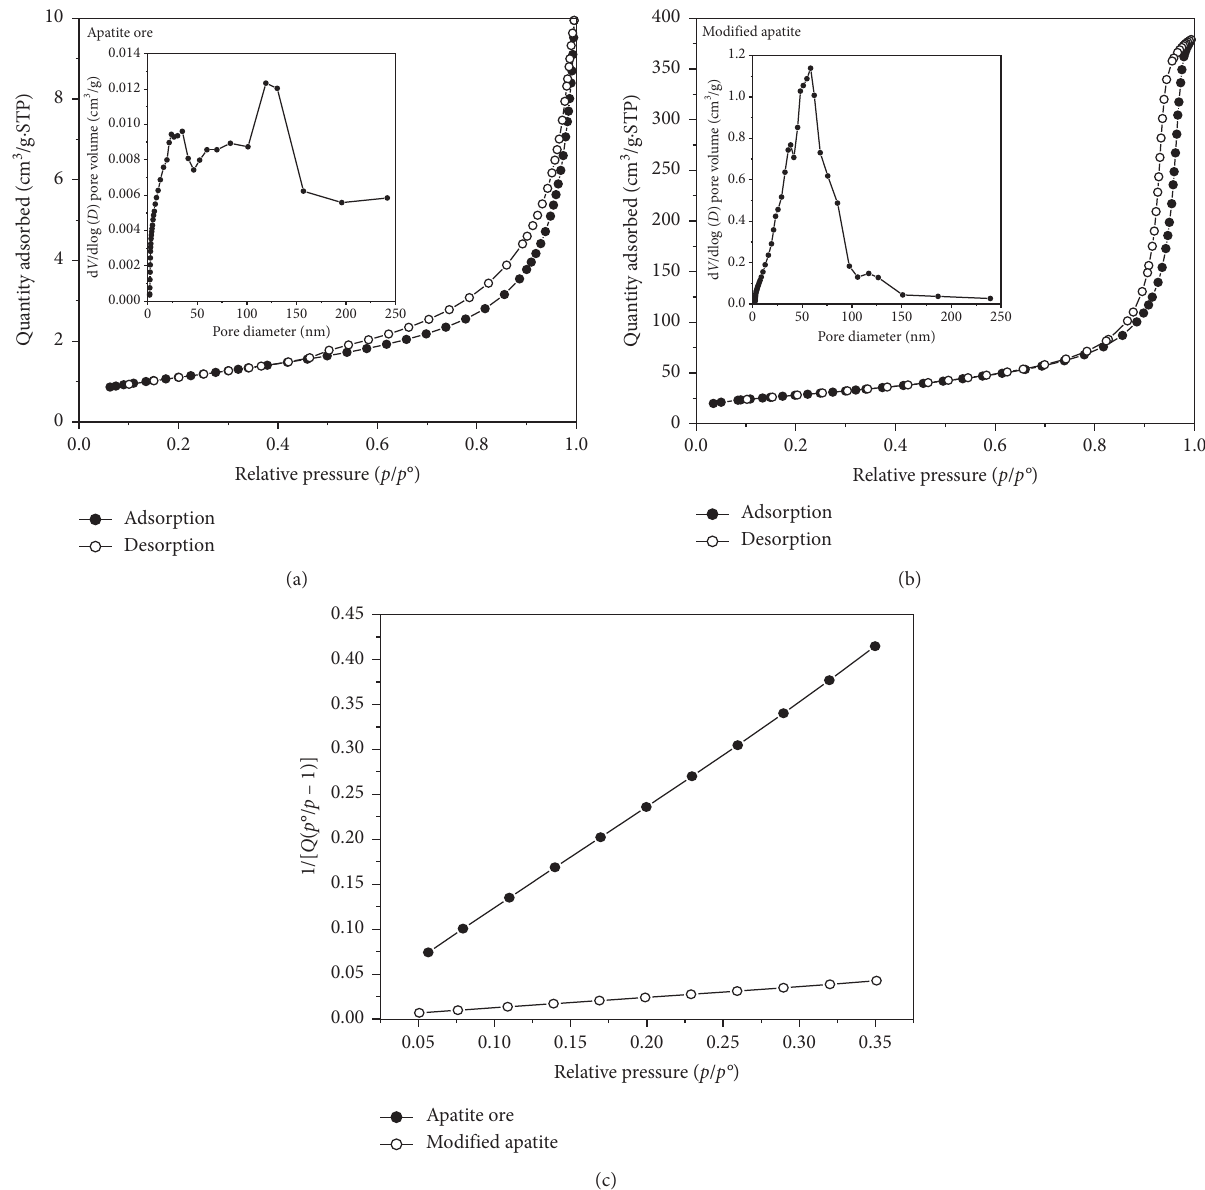
Figure 4: The N 2 adsorption-desorption isotherm and the pore size distributions of apatite ore (a), modified apatite (b), and BETplot (c) of apatite ore before and after